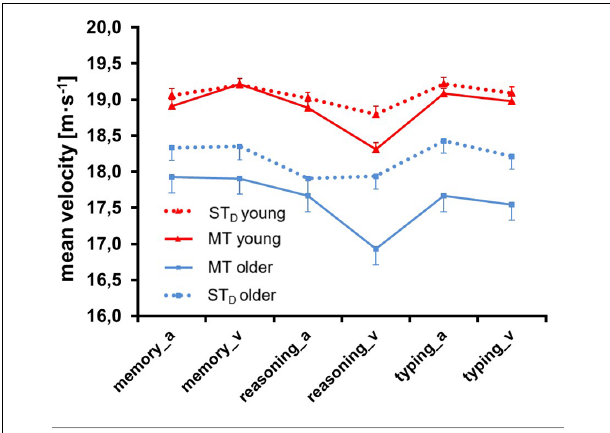
FIGURE 5 | Mean velocity ± SE of both age groups in single task (ST D ) and multitask (MT) conditions. Memory, reasoning and typing task were presented auditorily (_a) and visually (_v). FIGURE 6 | Standard deviation of velocity ± SE of both age groups in single task (ST D ) and multitask (MT) conditions. Memory, reasoning and typing task were presented auditorily (_a) and visually (_v).